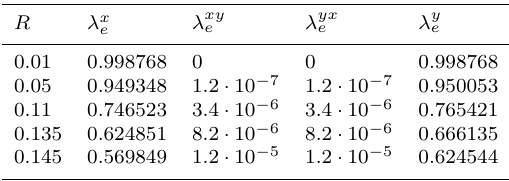
Table 3. The components of the effective conductivity tensor Λ e for the configuration of the inclusions given in (4.1) for the material constants λ k = 0 . 01, γ k = 100, β k = − 0 . 01, M =